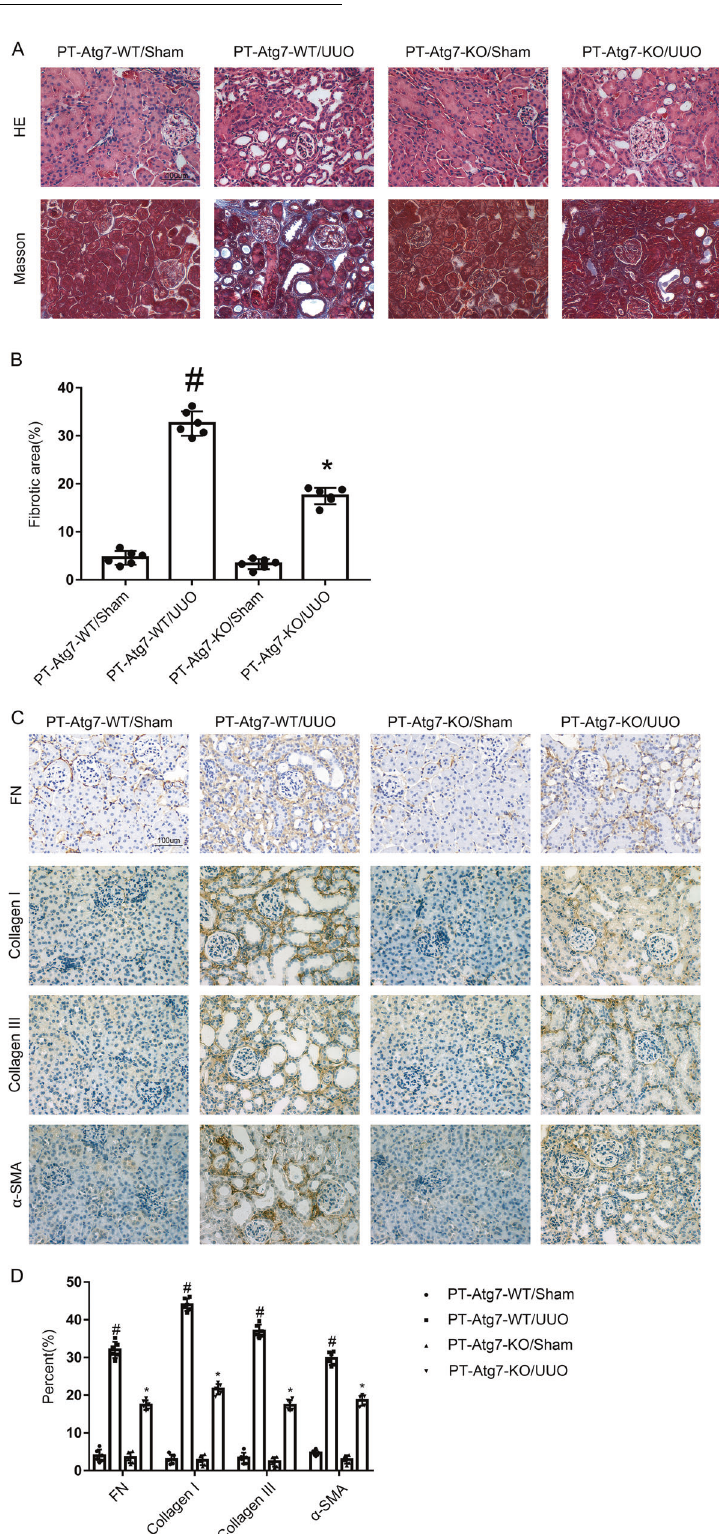
Fig. 6 Amelioration of UUO-induced renal fi brosis in PT-ATG7-KO mice. The left ureter of PT-ATG7-KO and PT-ATG7-WT littermate mice was ligated for 7 days to establish a UUO model. A Hematoxylin and eosin staining and the representative Masson ’ s trichrome staining. B Quanti fi cation of tubulointerstitial fi brosis in the kidney cortex. C Immunohistochemistry of FN & Collagen I & Collagen III and α -SMA staining. D Quanti fi cation of the FN & Collagen I & Collagen III and α -SMA -positive cells in the kidney cortex. Original magni fi cation ×400. Scale bar:100 µM. Data are expressed as means ± s.d. ( n = 6). # P < 0.05 versus PT-ATG7-WT with the sham group. * P < 0.05 versus PT-ATG7-WT with the UUO group. Each experiment A , C was repeated six times independently with similar results. B , D indicate the statistical Student ’ s t test used (means ± s.d., n = 6, P <